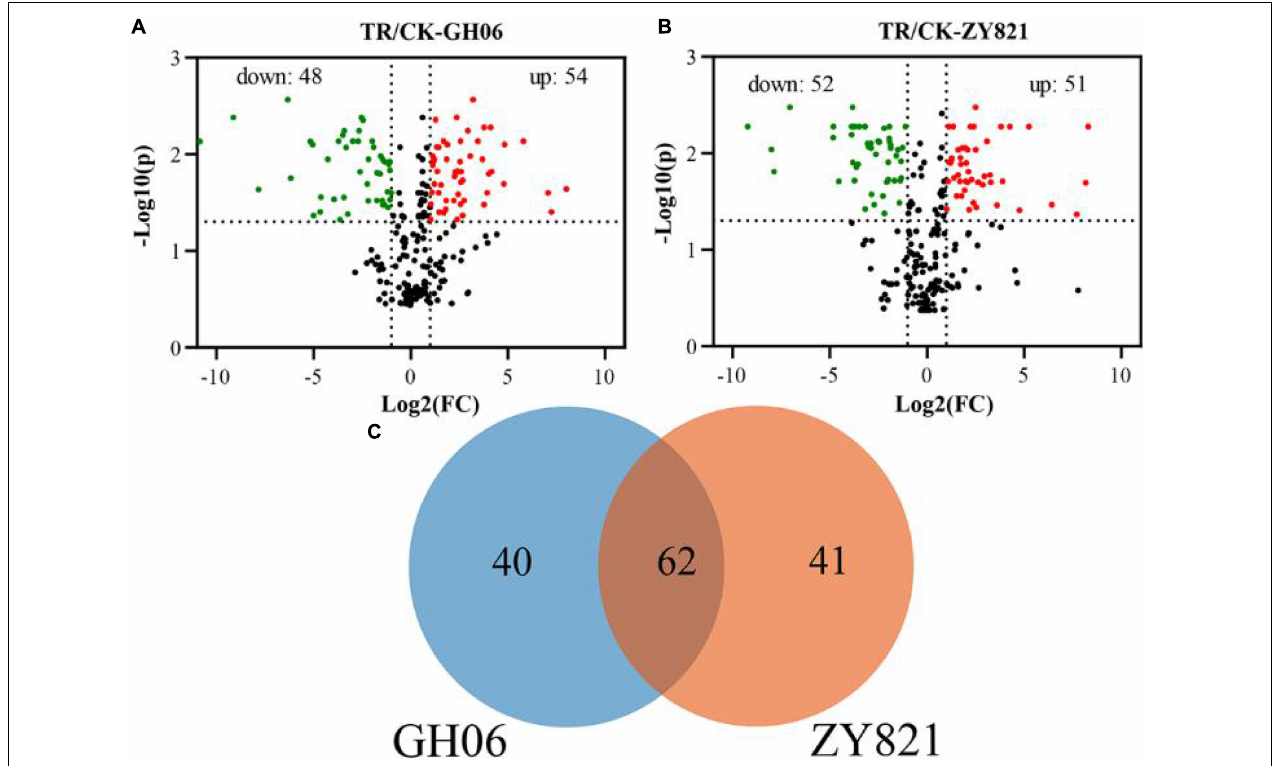
FIGURE 3 | The differential metabolites in siliques of rapeseed. (A,B) Volcano plots of differential metabolites in siliques of GH06 and ZY821 under shading treatment and the control, each point in a volcano plot represents a metabolite; the abscissa represents the logarithm of the quantitative difference multiples of a metabolite in two samples; and the ordinate represents the variable importance in project (VIP) value, CK, the control; TR, shading treatment. (C) Venn diagram of differential metabolites in siliques of GH06 and